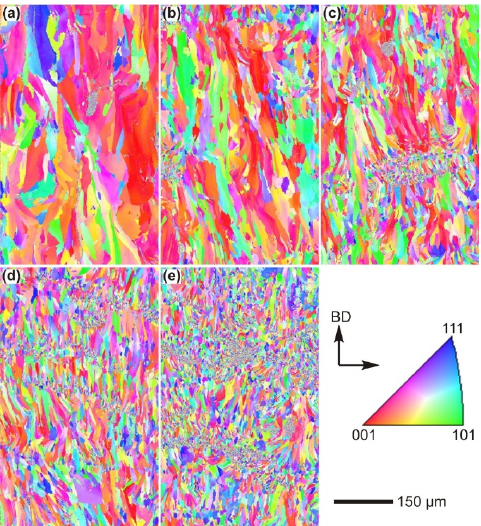
Figure 47. EBSD orientation maps of samples with different concentrations of Si: 0 wt.% ( a ), 1 wt.% ( b ), 2 wt.% ( c ), 3 wt.% ( d ) and 4 wt.% ( e ). The observed plane is parallel to the building direction.